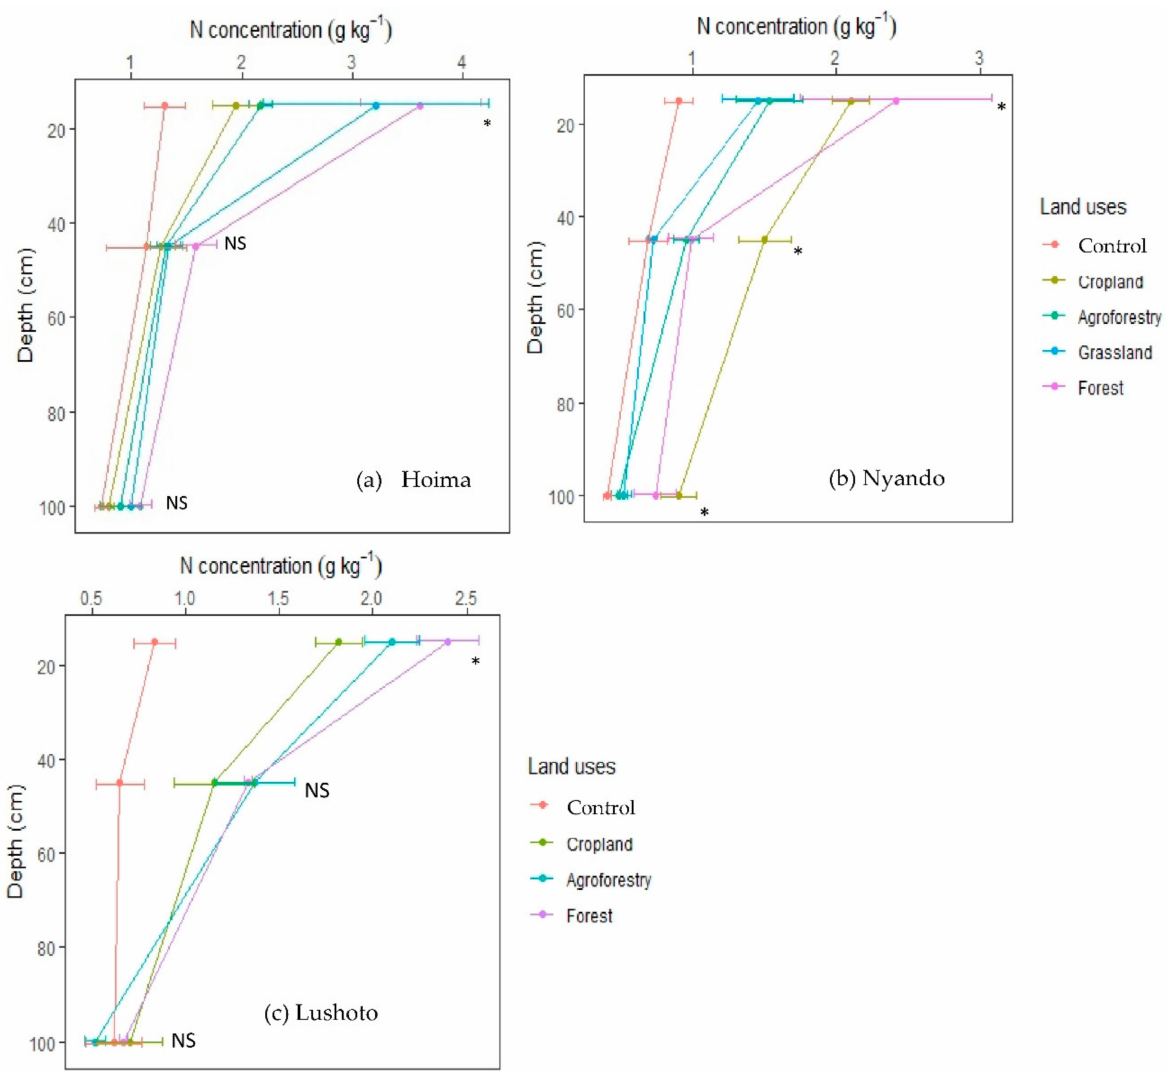
Figure 2. Nitrogen concentration in ( a ) Hoima, ( b ) Nyando, and ( c ) Lushoto at different land uses: cropland, agroforestry, grassland, forest, and control at different soil depths. Error bars represent the standard error of mean. NS denotes nonsignificant differences; * denotes significant differences at p ≤ 0.05,